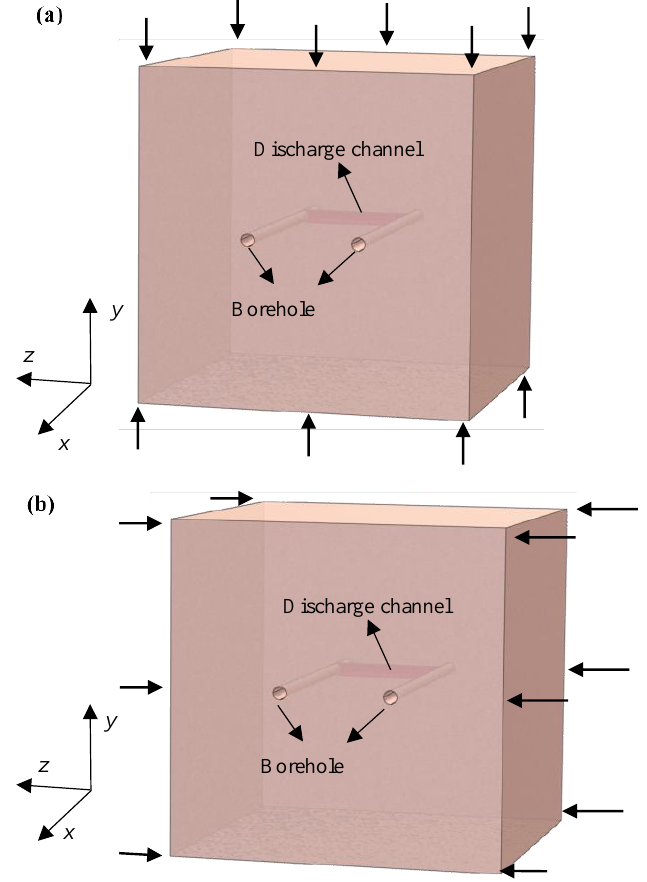
Figure 4. The coordinate system and static pressure loading mode: ( a ) Loading along the y -direction; ( b ) Loading along the z -direction.